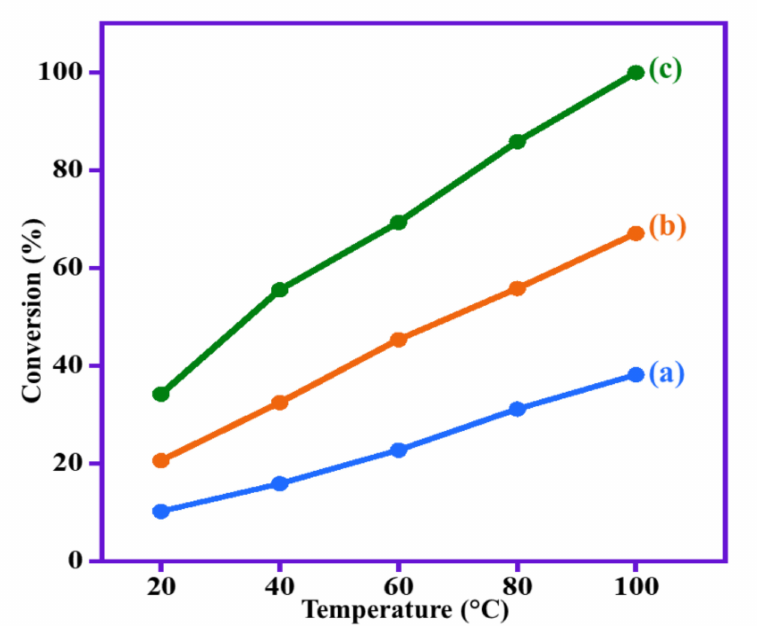
Figure 10. Impact of operation temperature on BOH dehydrogenation using ( a ) MnCO 3 , ( b ) (1%)ZnO– MnCO 3 , and ( c ) (1%)ZnO–MnCO 3 /(1%-NDG).